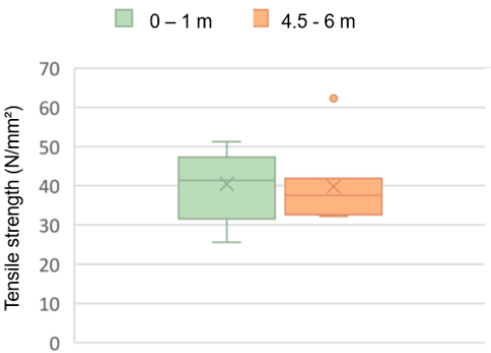
Figure 18. Tensile strength of Paulownia samples extracted at 0 − 1 m and 4.5 − 6 m from the tree stem.